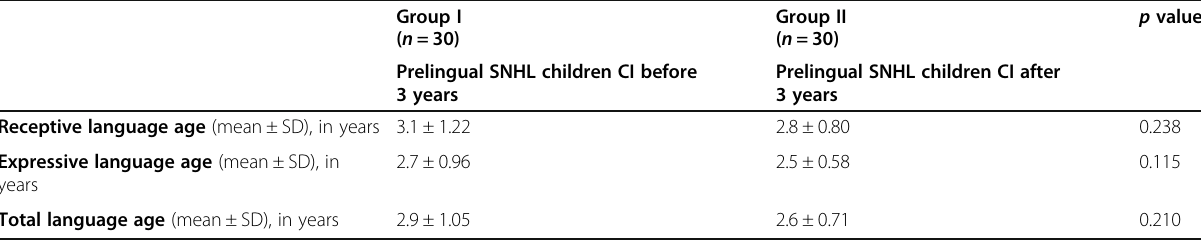
Table 3 Mean and standard deviation (SD) values of the receptive, expressive, and total language ages by the Modified Pre-school Language Scale-4, Arabic version and comparison between their values among the 2 studied groups